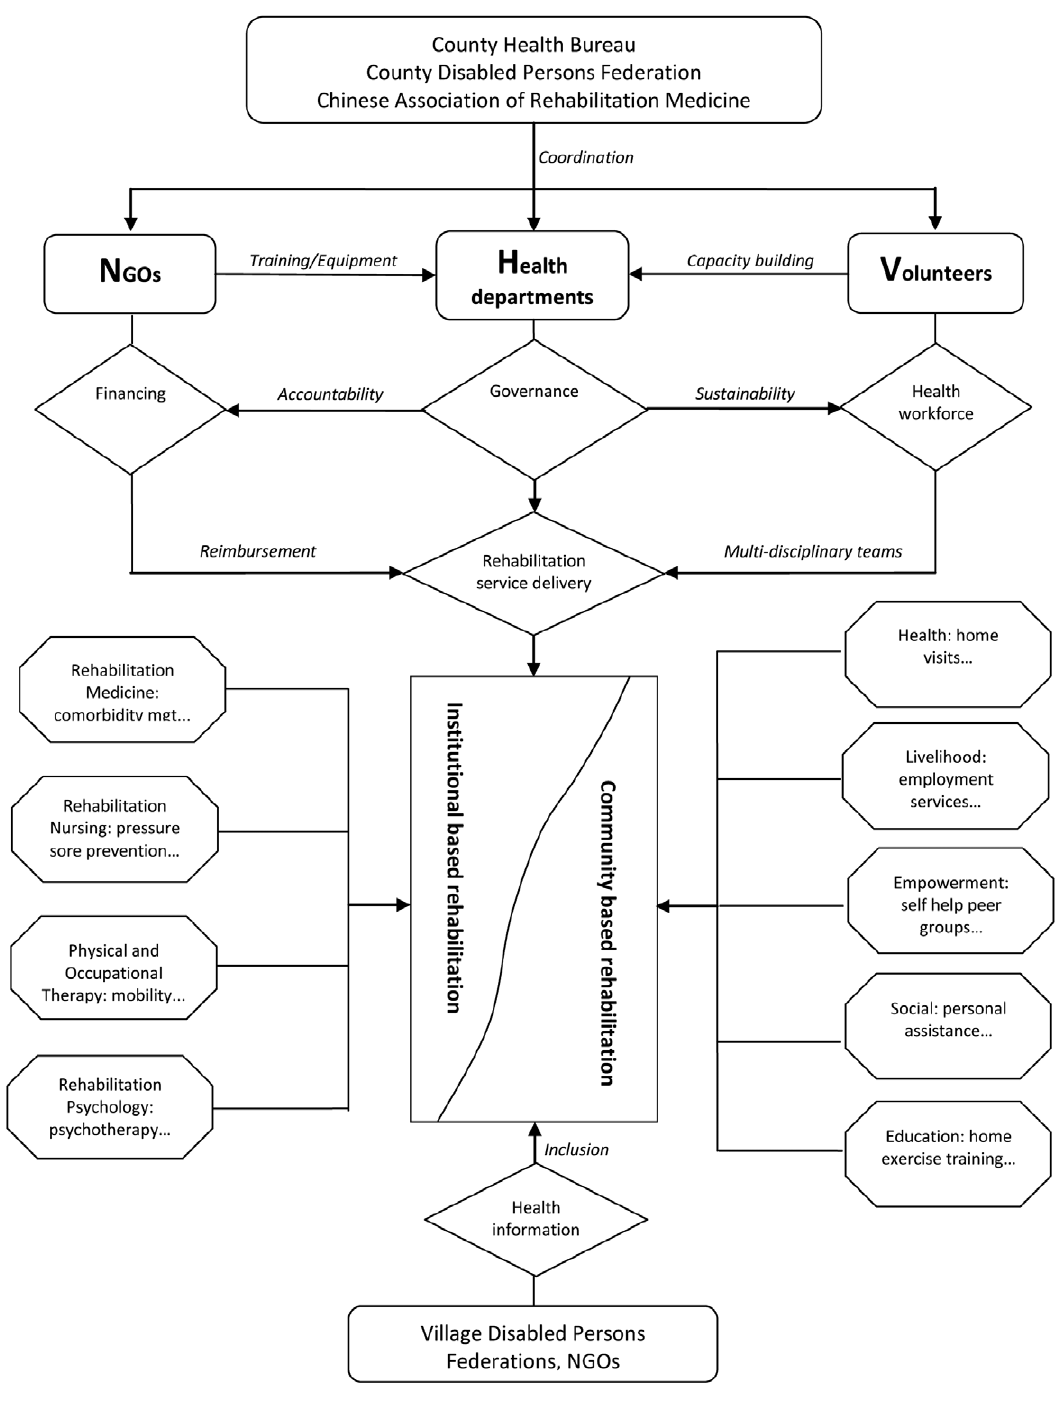
Figure 1. NHV program components and rehabilitation services.